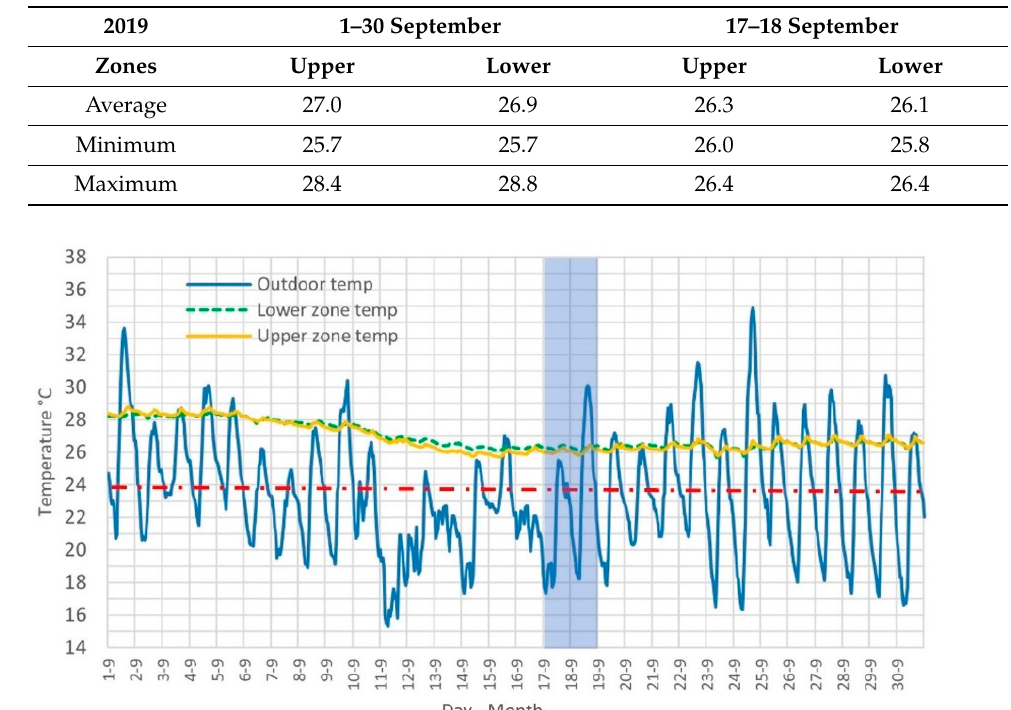
Figure 6. Average hourly ambient temperature EMS values in upper and lower main nave zones of Santos Juanes church in September 2019. The dotted red line represents the maximum value of the admissible temperature range for the conservation of fresco paintings [63]. The blue rectangle represents the period of two characteristic days selected for the 3D-TCV test. Table 2. Average monthly ambient temperature EMS values in the upper and lower main nave zones of Santos Juanes church in September 2019 compared with average values of two character- istic days selected for the 3D-TCV test.